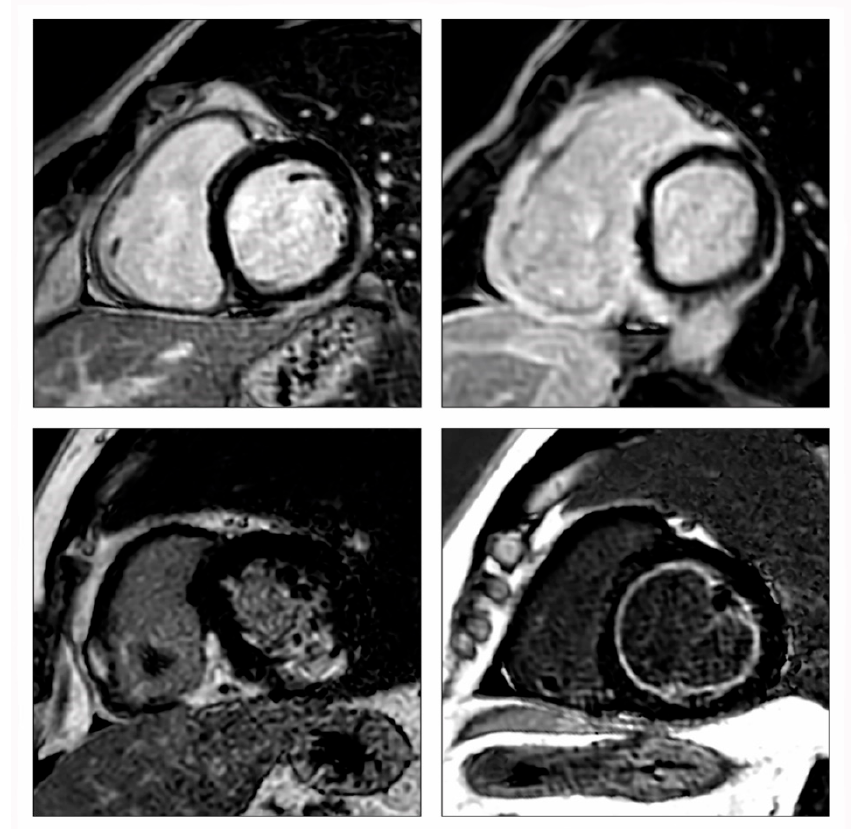
Figure 2. Characteristic late gadolinium enhancement (LGE) patterns in viral myocarditis ( upper left , inferolateral subepicardial LGE), giant cell myocarditis ( upper right , complex LGE involving both ventricles including the right ventricular insertion points), cardiac sarcoidosis ( lower left , com- plex LGE involving both ventricles including the inferior right ventricular insertion point), and eo- sinophilic myocarditis ( lower right , diffuse subendocardial LGE with high signal intensity).